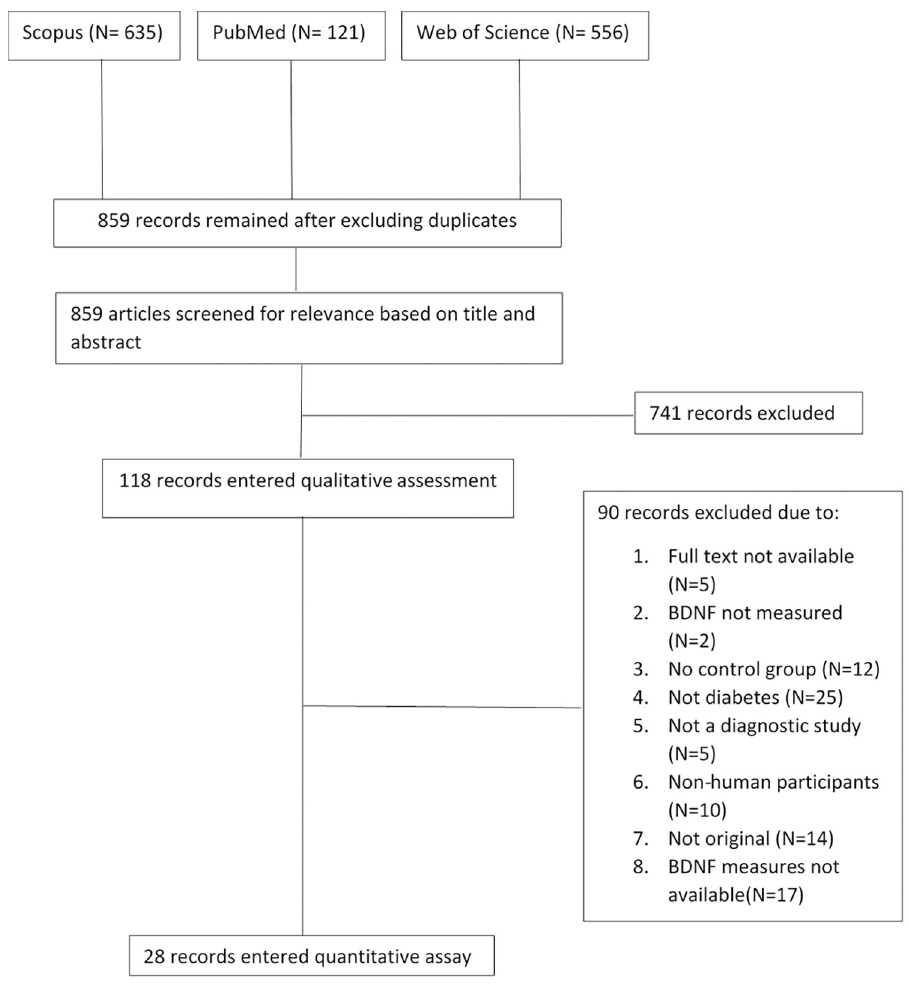
Fig 1. Search method and study